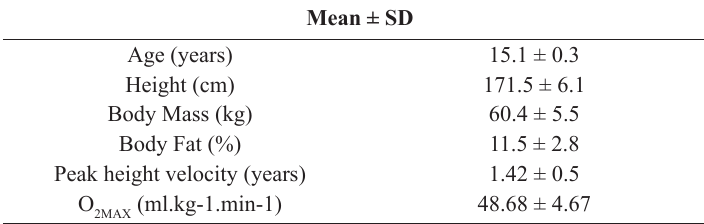
Table 1. Sample characteristics expressed in mean ± sd of age, height, body mass, body fat, peak height velocity and O2MAX.